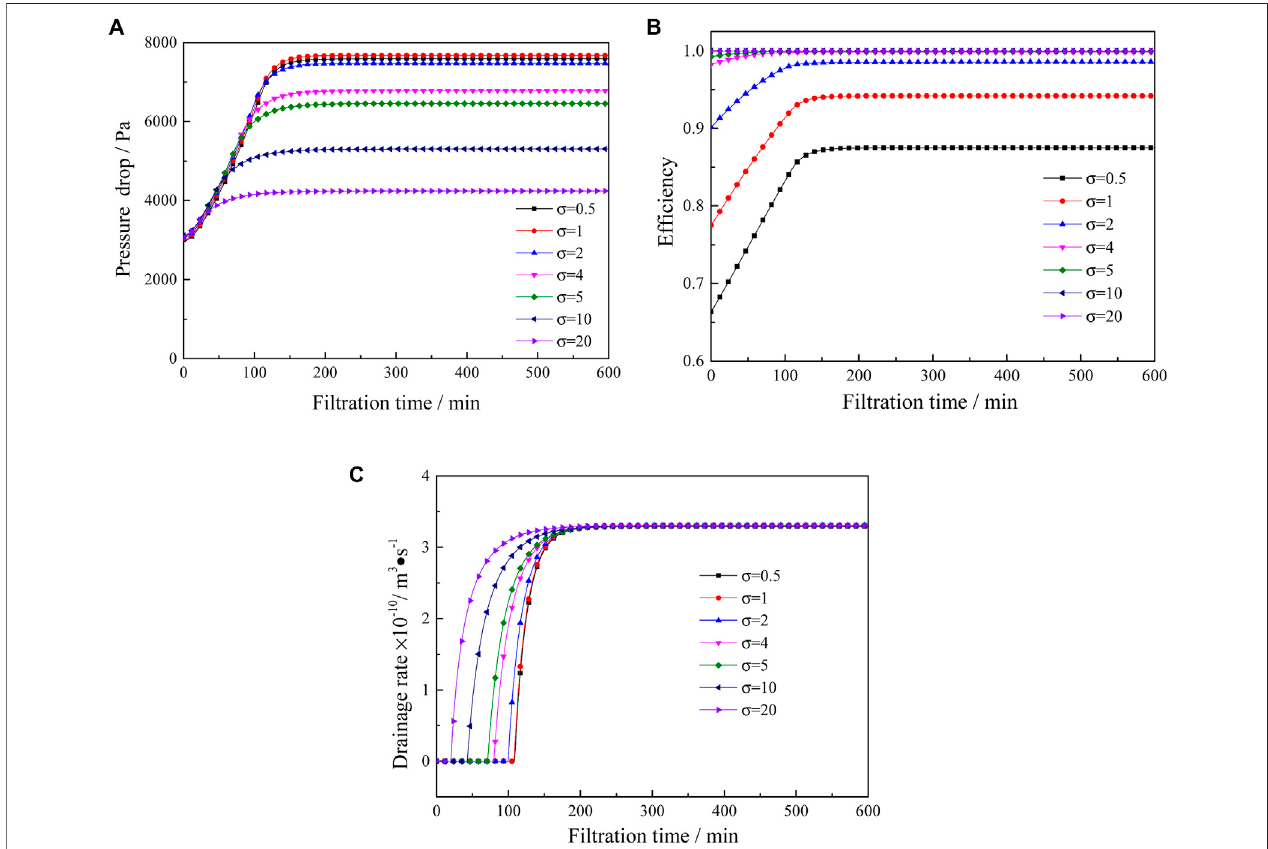
FIGURE 5 | Diagram of variation of fi ber dispersion on fi lter performance of fi lter: (A) Dynamic pressure drop; (B) Filtration ef fi ciency; (C) Drainage rate.